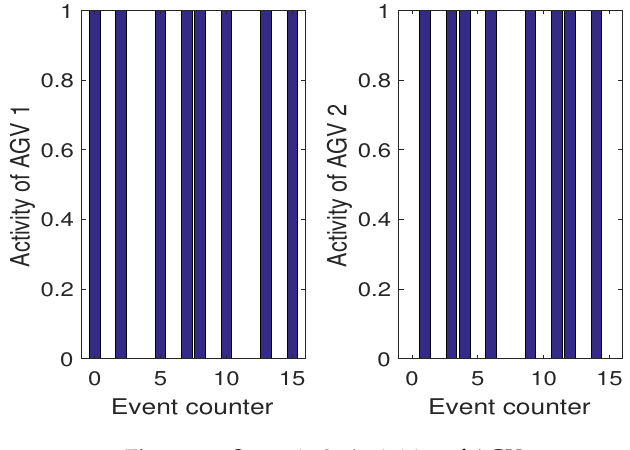
Figure 18. Scenario 2: Activities of AGVs.